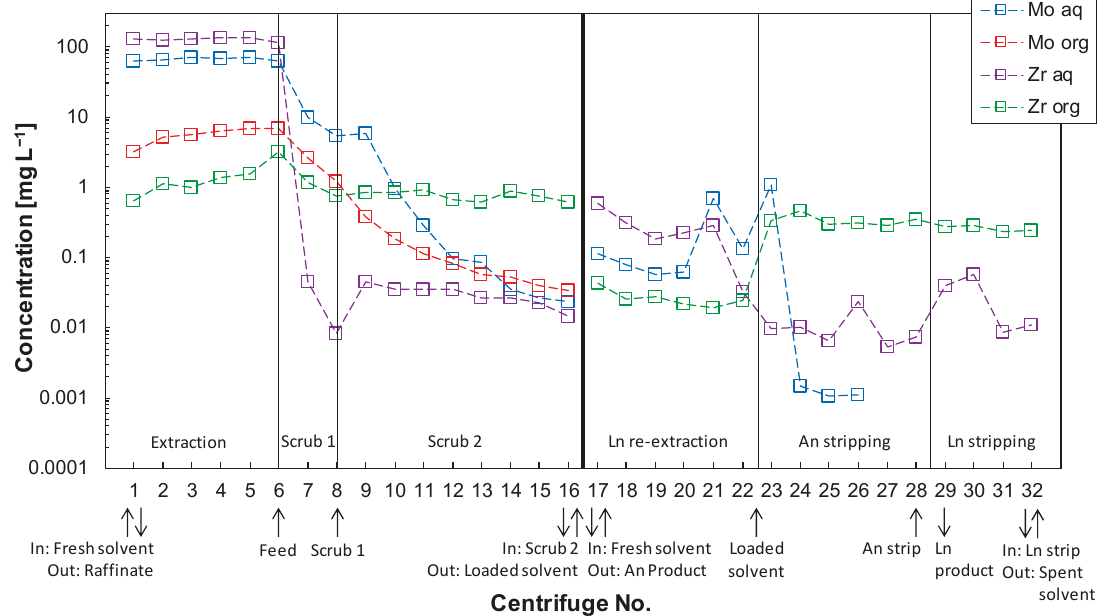
Figure 10. Mo and Zr stage profiles of the ALSEP demonstration test (data from ICP-MS measurements).